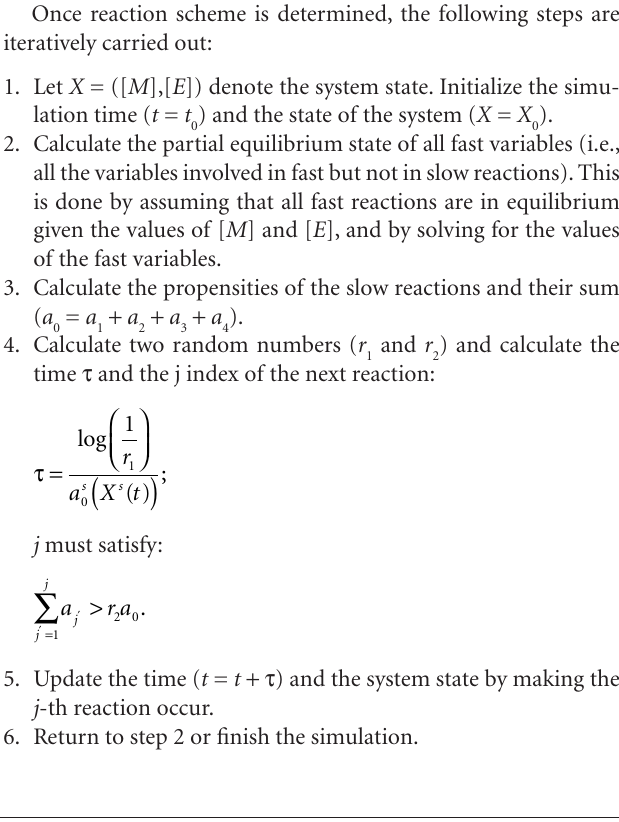
y K , which were re- A T